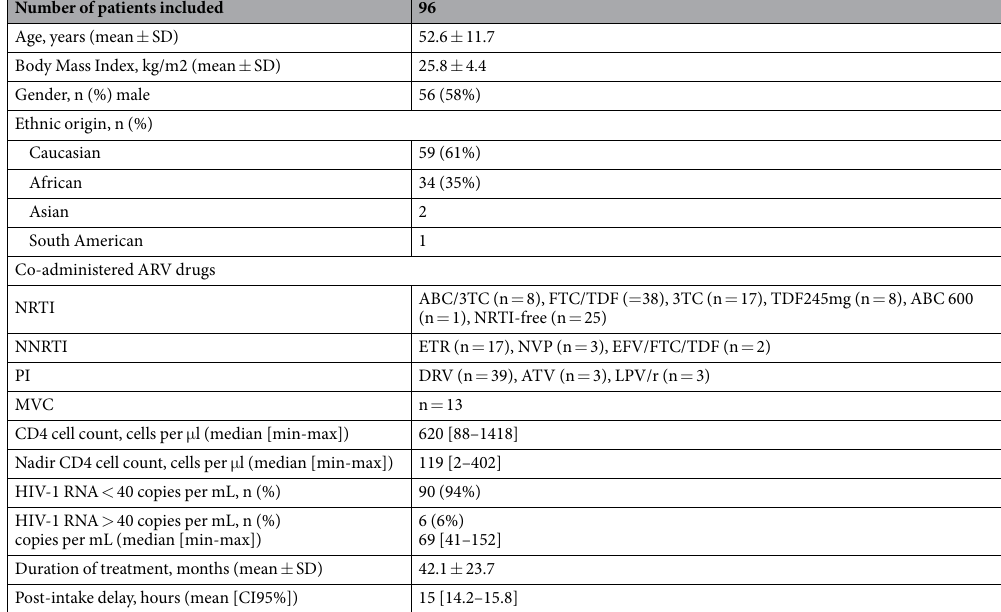
Table 1. Main characteristics of the patients at day of inclusion. ARV: antiretroviral, NNRTI: Non-Nucleoside Reverse Transcriptase Inhibitor, NRTI: Nucleoside Reverse Transcriptase Inhibitor, PI: protease inhibitor, DRV: darunavir, ATV: atazanavir, LPV/r: Lopinavir/ritonavir, MVC: maraviroc ETR: etravirine, NVP: nevirapine, ABC: abacavir, 3TC: lamivudine, FTC: emtricitabine, TDF: tenofovir disoproxil fumarate, NRTI-free: without any